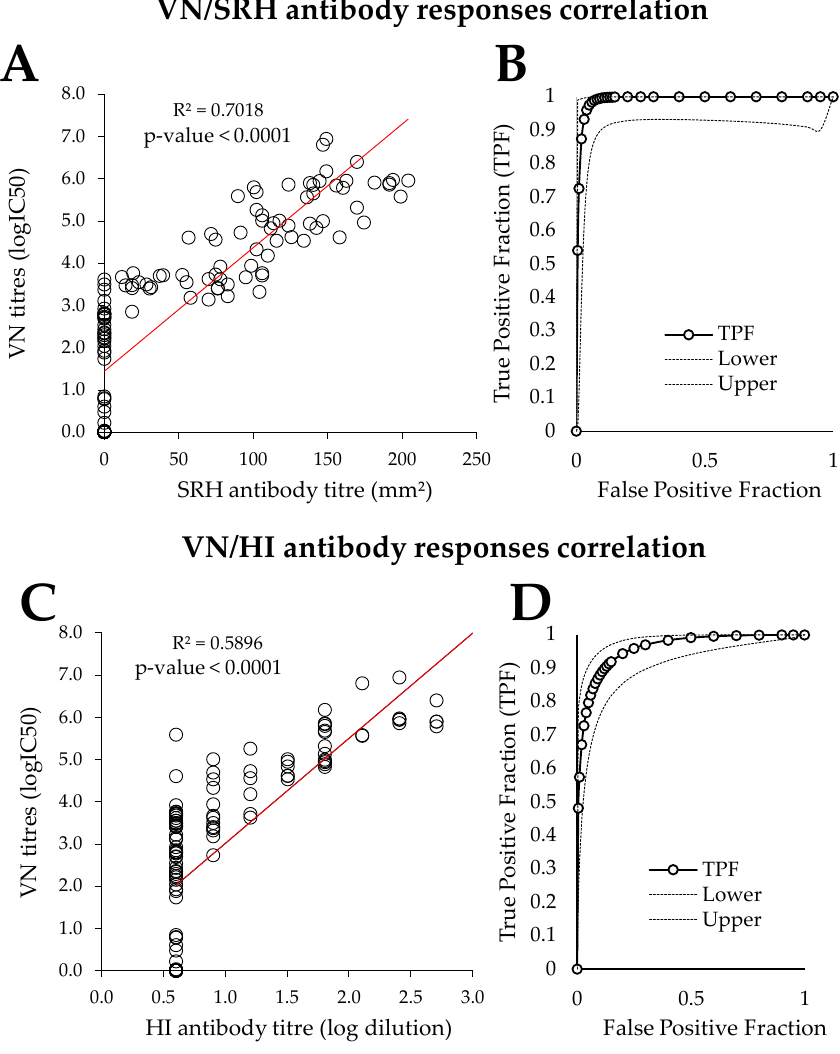
Figure 3. Pseudotype virus neutralization (VN)/single radial haemolysis (SRH) and VN/hemaglutination Inhibition (HI) assay (A and C, respectively), as well as receiver operating characteristic (ROC) curve analysis (B and D, respectively). Results from both serum sets were used ( n = 134). TPF: true positive fraction.